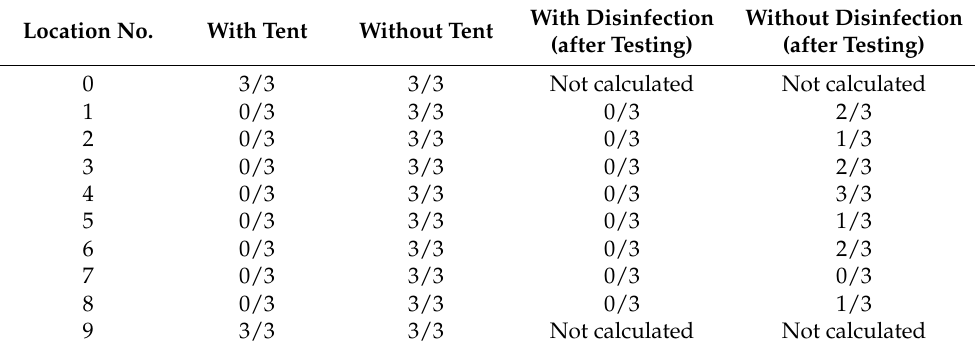
Table 3. The RT-qPCR results under different conditions (positive case/total test times). Location No. With Tent Without Tent